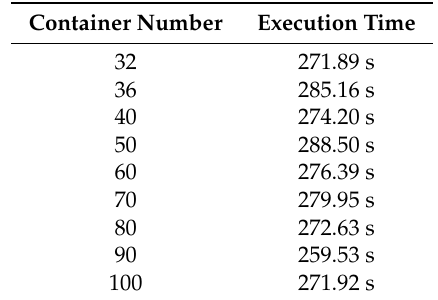
Table 4. The impact of container number to the efficiency of SNNQAs using ASVC and setting p = 3000 and k = 5.